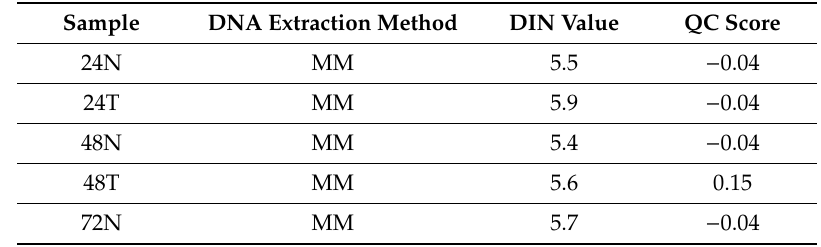
Table 4. DNA quality evaluation using fluorescent capillary electrophoresis (TapeStation) and real-time PCR quantification